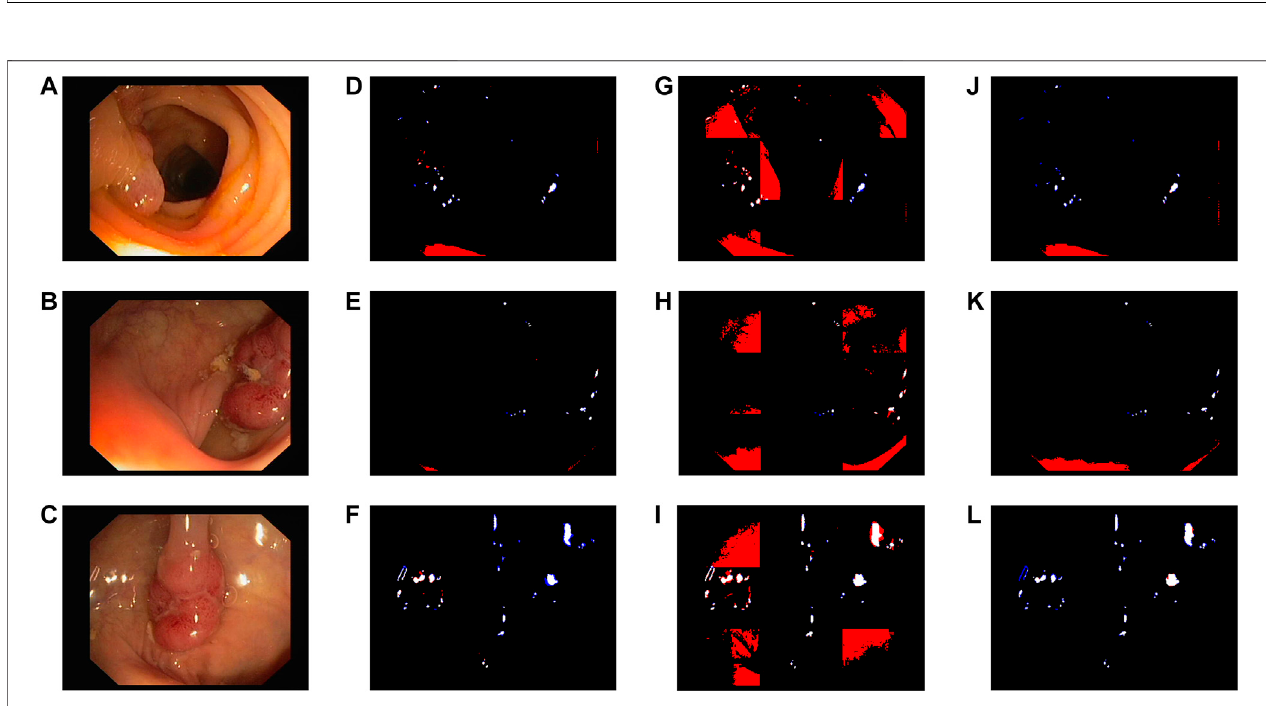
FIGURE 3 | Performance of the proposed highlight detection method with different traversal methods. (A) – (C) Original images from CVC-ClinicSpec. (D) – (F) 50% overlappedwindowsone-fourththesizeoftheoriginalimages. (G) – (I) Nonoverlappedwindowsone-ninththesizeoftheoriginalimages. (J) – (L) Usingglobalinformation.